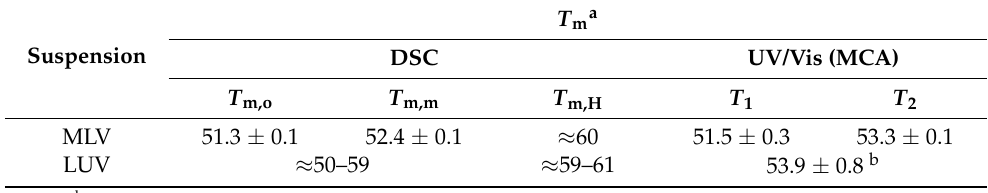
Table 1. Melting temperatures ( T m ) of DPPS-constituted MLV and LUV obtained from DSC curves (by measuring both onsets (o; T m,o ) and maxima (m; T m,m ) of the main phase transition of deprotonated DPPS and by estimating the curve maximum (MLV)/interval (LUV) of protonated ones, respectively ( T m,H ) and those obtained from a double (MLV; T m,1 and T m,2 ) and single (LUV; T m ) sigmoid fit of spectral projections of temperature-dependent UV/Vis